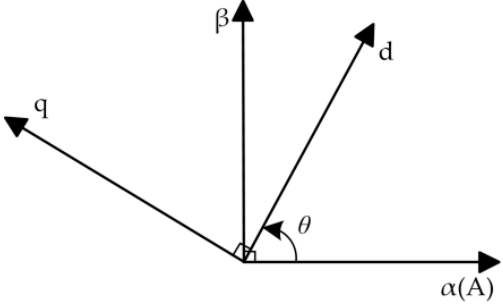
Figure 2. Relationship between the reference frames.